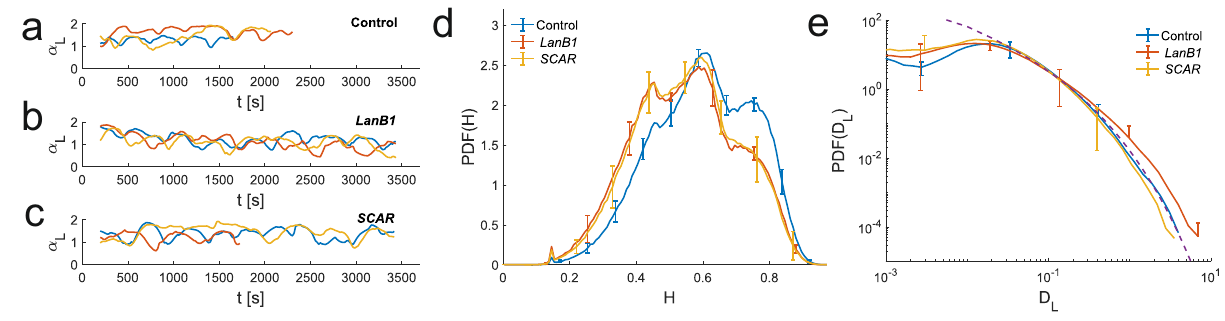
Fig. 4 Hemocytes are characterized by distributions of time dependent anomalous exponents and generalized diffusion coef fi cients. a – c Local anomalous exponents α L ( t ) for representative hemocyte trajectories in a control, LanB1 and SCAR embryo. α L ( t ) display oscillatory behaviour (color represents α L ( t ) for different trajectories). d Distributions of time dependent Hurst exponents H ( t ) estimated using the neural network. Notice that α = 2 H ( t ). Distributions of local generalized diffusion coef fi cients D fi t of the distribution tail with the Weibull density α L . The dashed line represents a L ( t ) function, PDF ð η Þ (cid:4) c ð η c (cid:3) 1 = η c Þ exp ð(cid:3)ð η = η Þ c Þ with c = 0.39 and η 0 = 0.008. The error bars in ( d ) and ( e ) correspond to 95% con fi dence 0 0